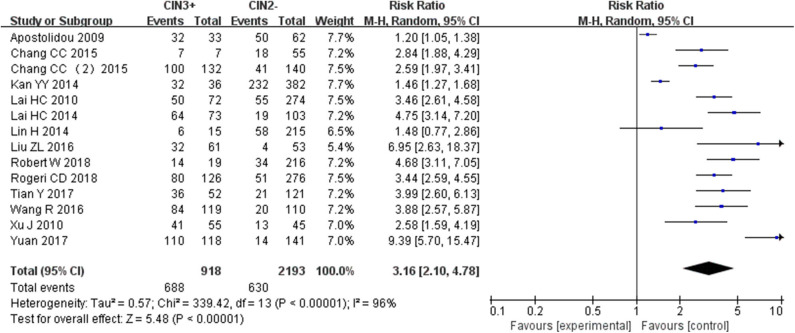
Forest plots for associations of SOX1 promoter hypermethylation with the risk of CIN3+. The squares represent the ORs for individual studies. The size of the square reflects the weight of included studies. Bars represent the 95% confidence intervals (CIs). The center of the diamond represents the summary effect size.